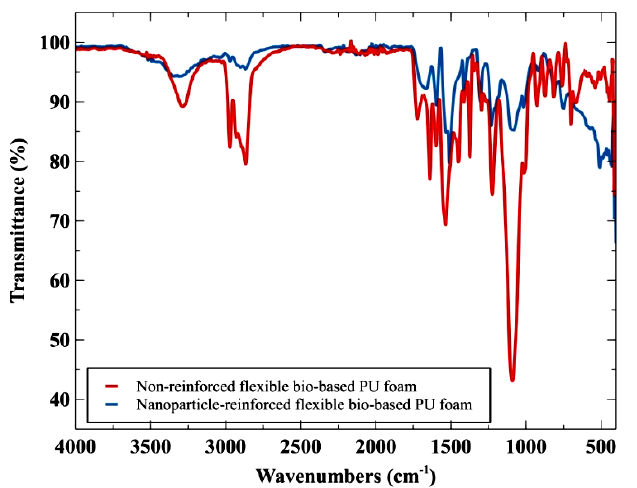
Figure 4. FTIR graph of non-reinforced and nanoparticle-reinforced flexible bio-based polyurethane foam.